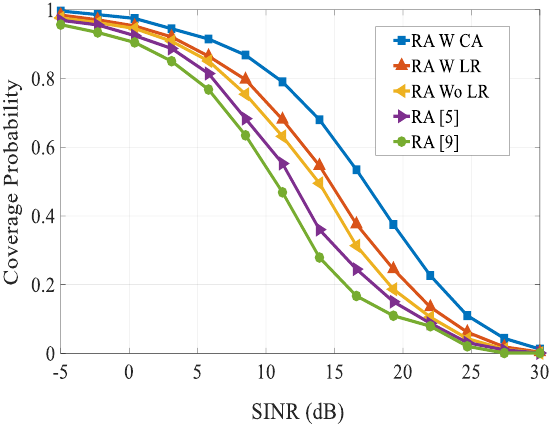
Figure 6. Coverage probability vs. SINR performance.